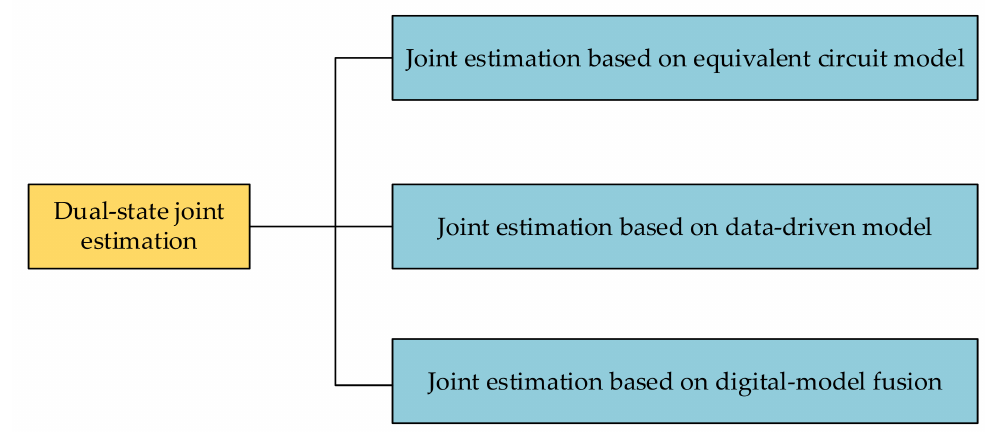
Figure 9. The classification of dual-state estimation methods.